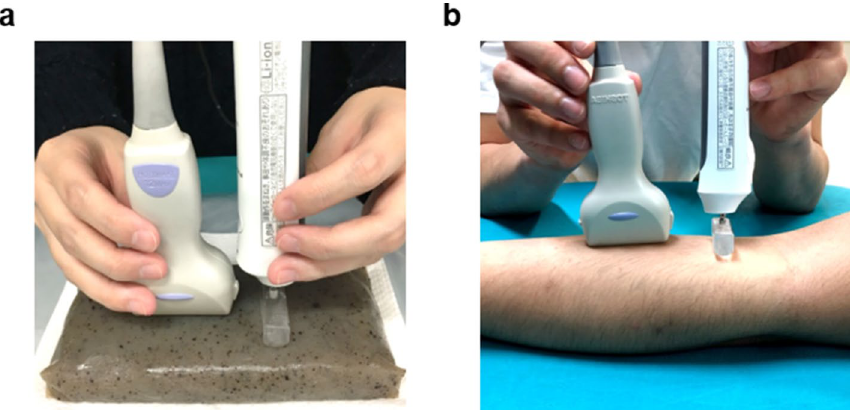
Figure 6. Photograph of the experiment. (a) Photograph of the phantom experiment. The phantom in the photograph is a commercially available jelly made from konjac yam routs. (b) Photograph of the in vivo experiment using forearm skeletal